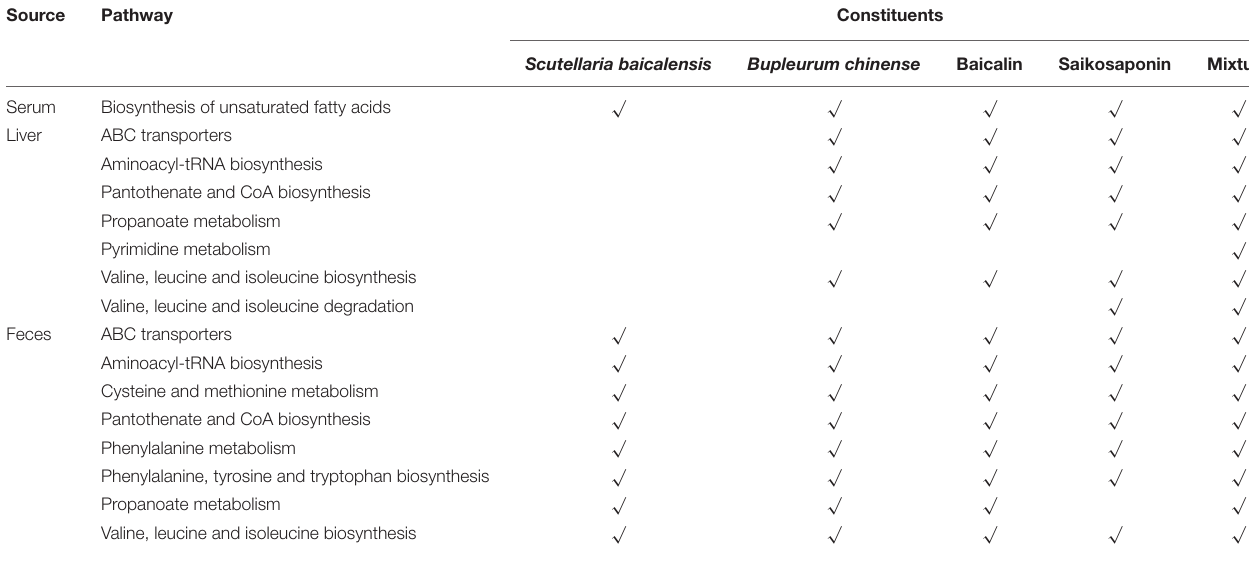
TABLE 2 | Contributions of the single herbs and their active ingredients to the disturbed pathways of B. chinense-S. baicalensis herbal pair. Source